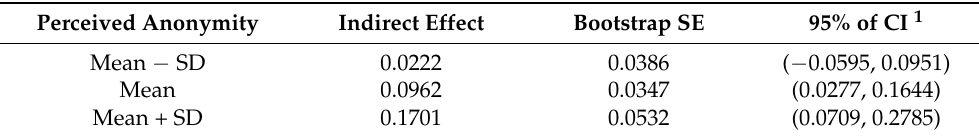
Figure 3. The moderating influence of PA on the association between ED and WOHS. Table 4. Moderated effect divided into three levels of perceived